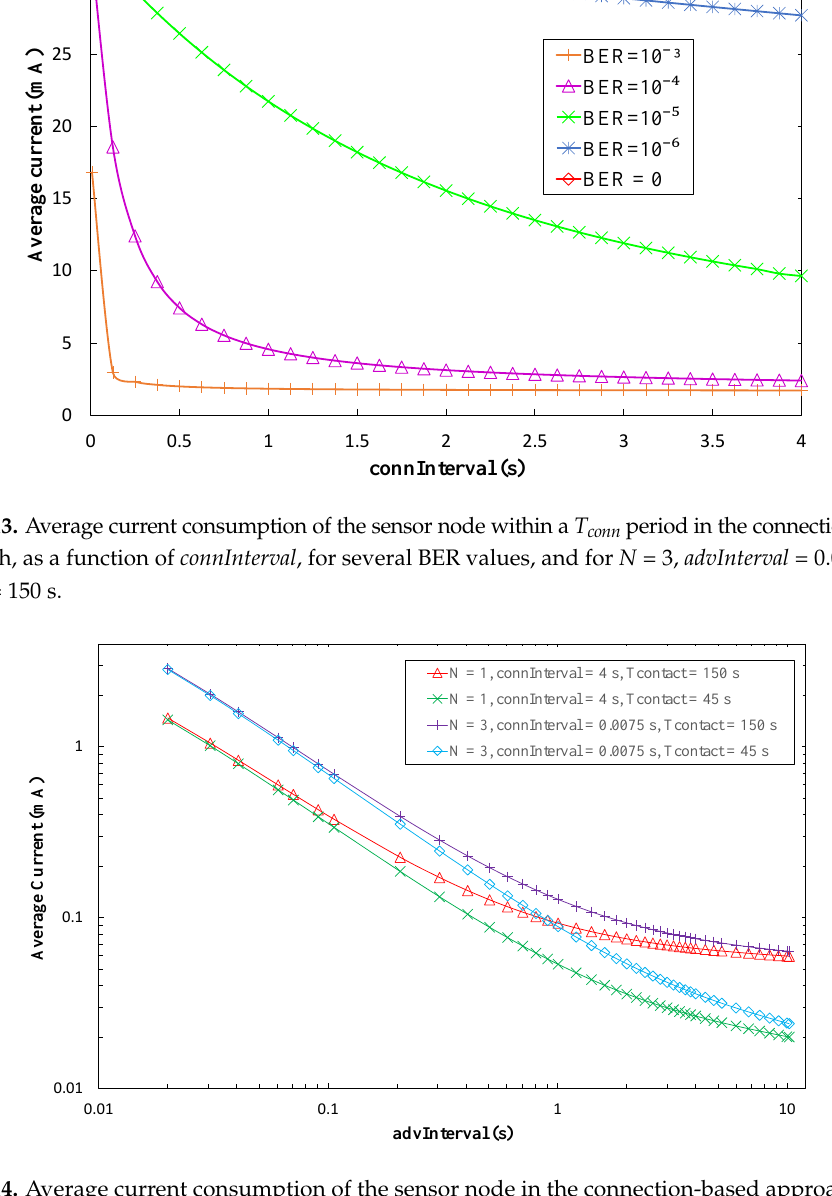
Figure 14. Average current consumption of the sensor node in the connection-based approach, for a time between contacts of one day, as a function of advInterval , and for different N and T contact , and for BER = 0. A theoretical value of T contact = 0 has been evaluated, however depicted results in the logarithmic representation used in the figure are very close to those of T contact = 45 s. Thus they have been excluded from the figure for the sake of clarity.